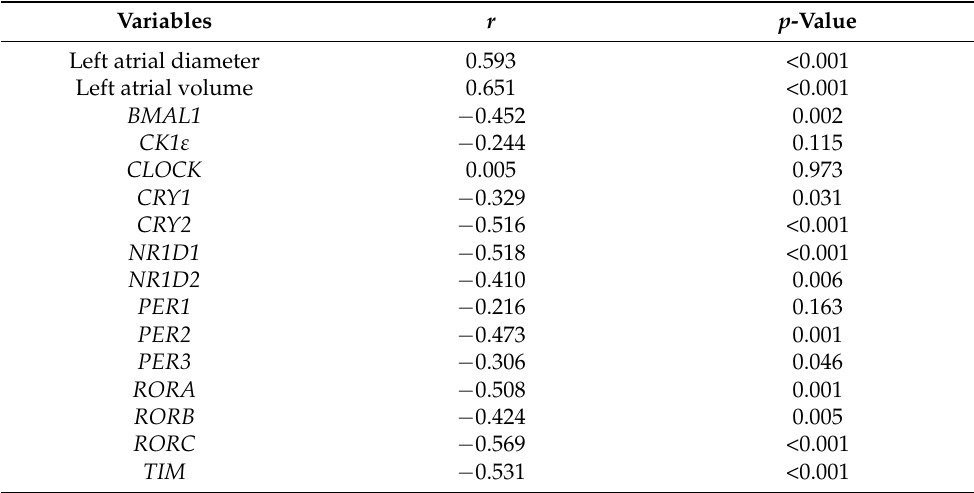
Table 2. Correlation between burden of atrial high-rate episodes (AHREs) and left atrial size, and correlation between AHRE burden and mRNA expression of circadian clock genes.